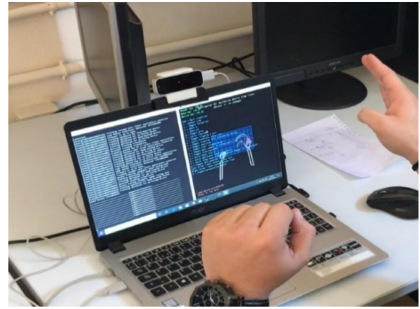
Figure 2. Recording of